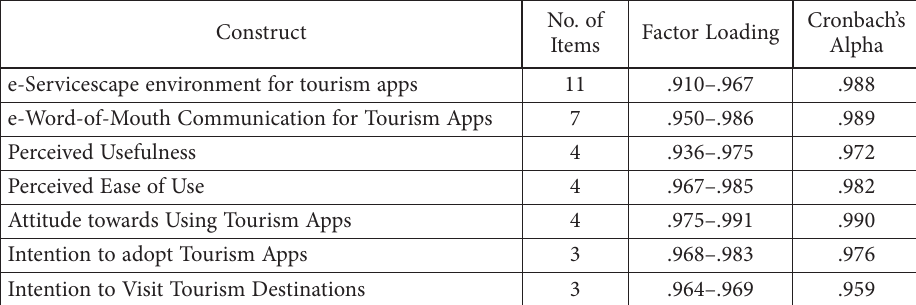
Table 2. Construct of factor analysis and reliability analysis